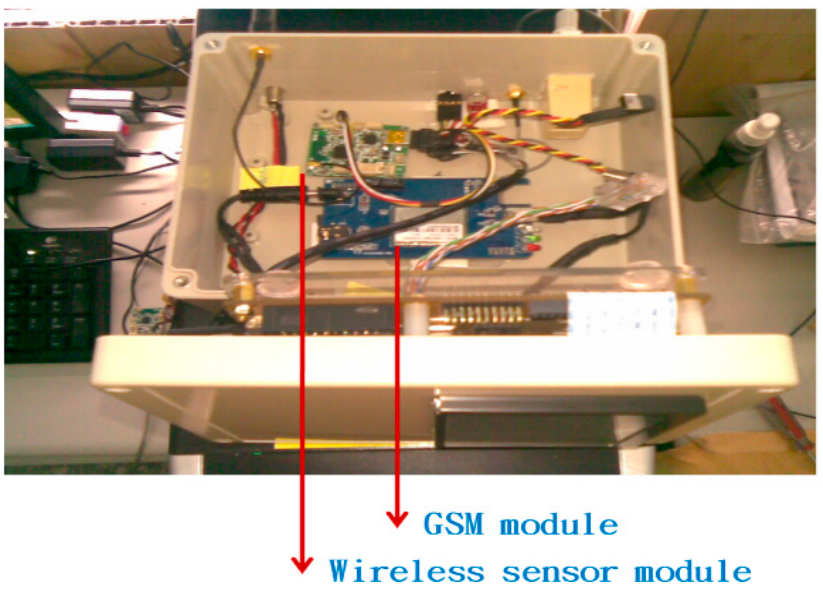
Figure 13. Interior components of the smart gateway.